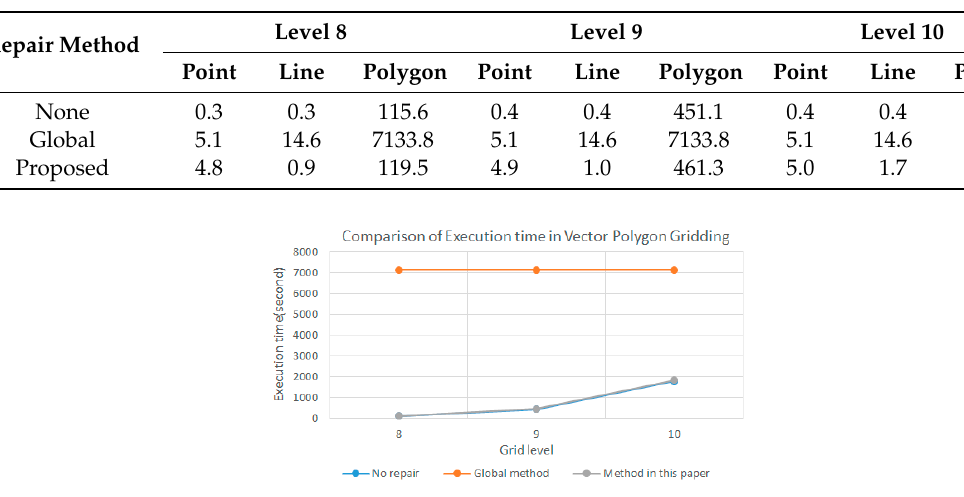
Figure 18. Comparison of the execution time of the gridding results of the three methods.